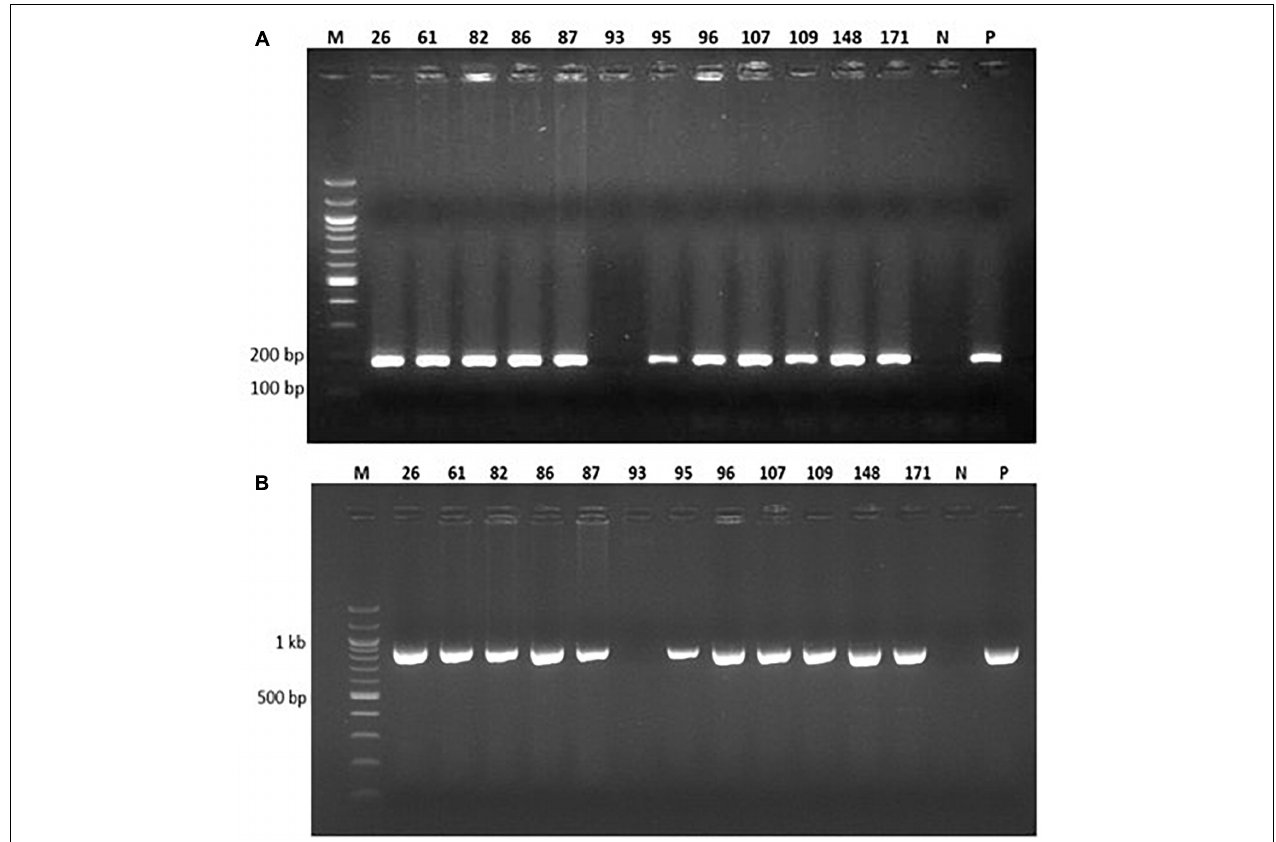
FIGURE 3 | PCR analysis of 12 representative putatively transgenic cowpea lines using (A) vip3Ba -specific primers designed to amplify a 187 bp product and (B) nptII -specific primers designed to amplify a 970 bp product. Lane M: DNA Molecular weight marker; Lane N: No template (negative control); Lane P: Plasmid DNA containing both vip3Ba and nptII genes (positive control); numbers above lanes represent the line number of randomly selected, independent transgenic cowpea plants.